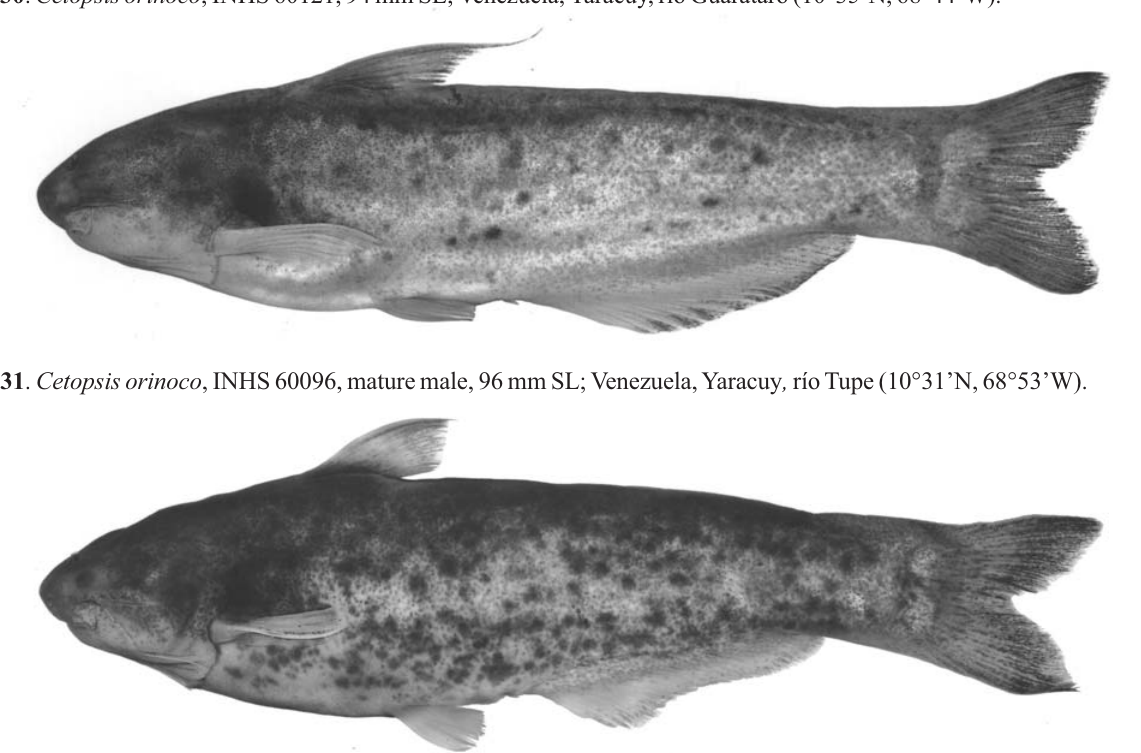
Fig. 30 . Cetopsis orinoco , INHS 60121, 94 mm SL; Venezuela, Yaracuy, río Guarataro (10°35’N, 68°44’W).